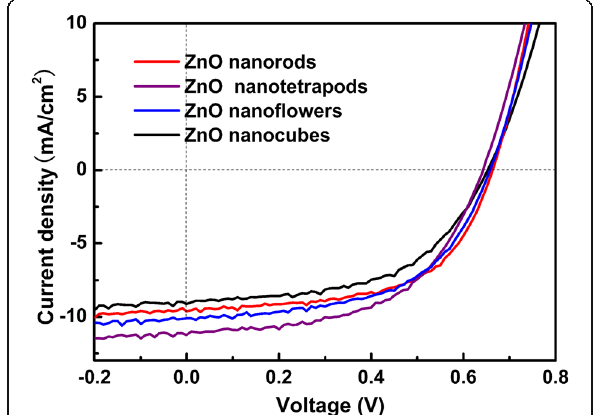
Fig. 4 J - V characteristics of the organic bulk heterojunction solar cells with different ZnO nanostructures